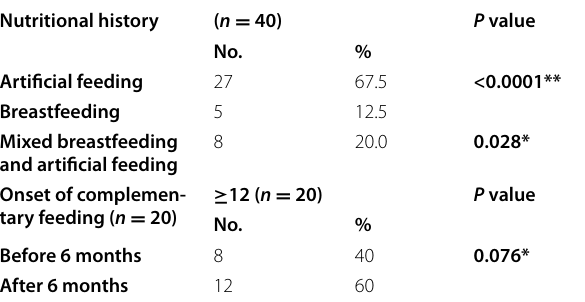
Table 3 Nutritional history of the studied cases Nutritional history Artificial